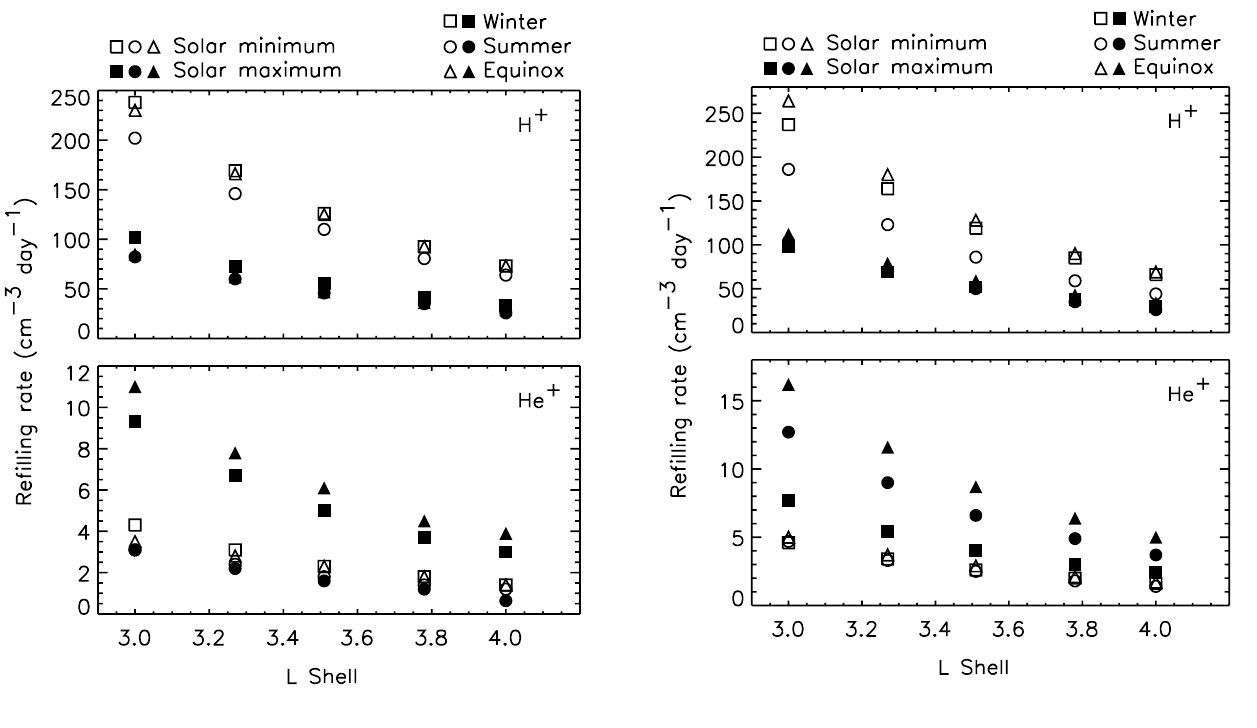
Fig. 6. Late-stage refilling rates for H + (top) and He + (bottom). All rates correspond to the magnetic equator and longitude 0.